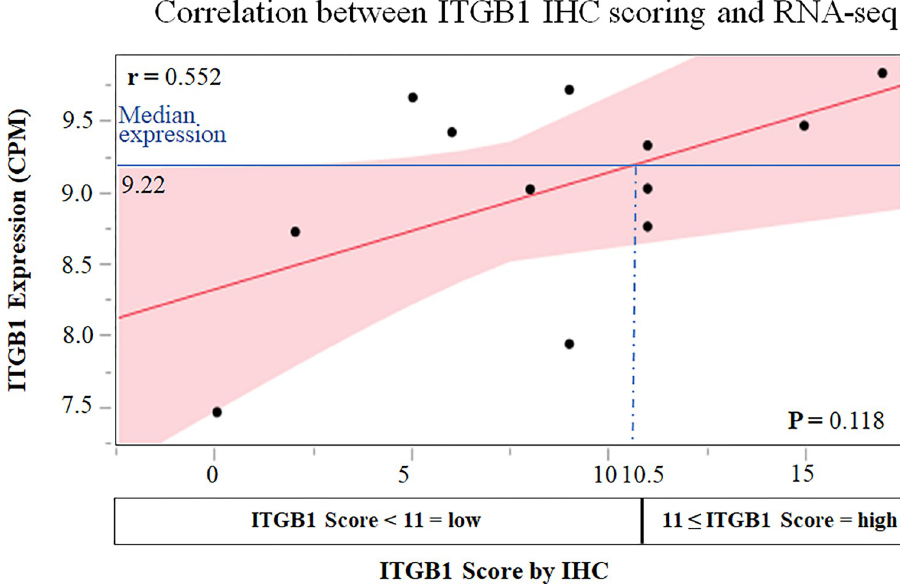
Fig 4. Correlation between IHGB1 IHC scoring and RNA-seq. IHCs scores were set on the X-axis, the RNA- sequencing expression levels were set on the Y-axis, and the correlation was graphed. Although the IHC score and RNA-sequencing expression tended to have a correlation, it was not significant (r = 0.552, ρ = 0.476, p = 0.118). For these relationships, a regression line was created, and the IHC score corresponding to the median RNA-expression level was calculated to be 10.5. Therefore, an IHC score � 11 signified high ITGB1 expression.